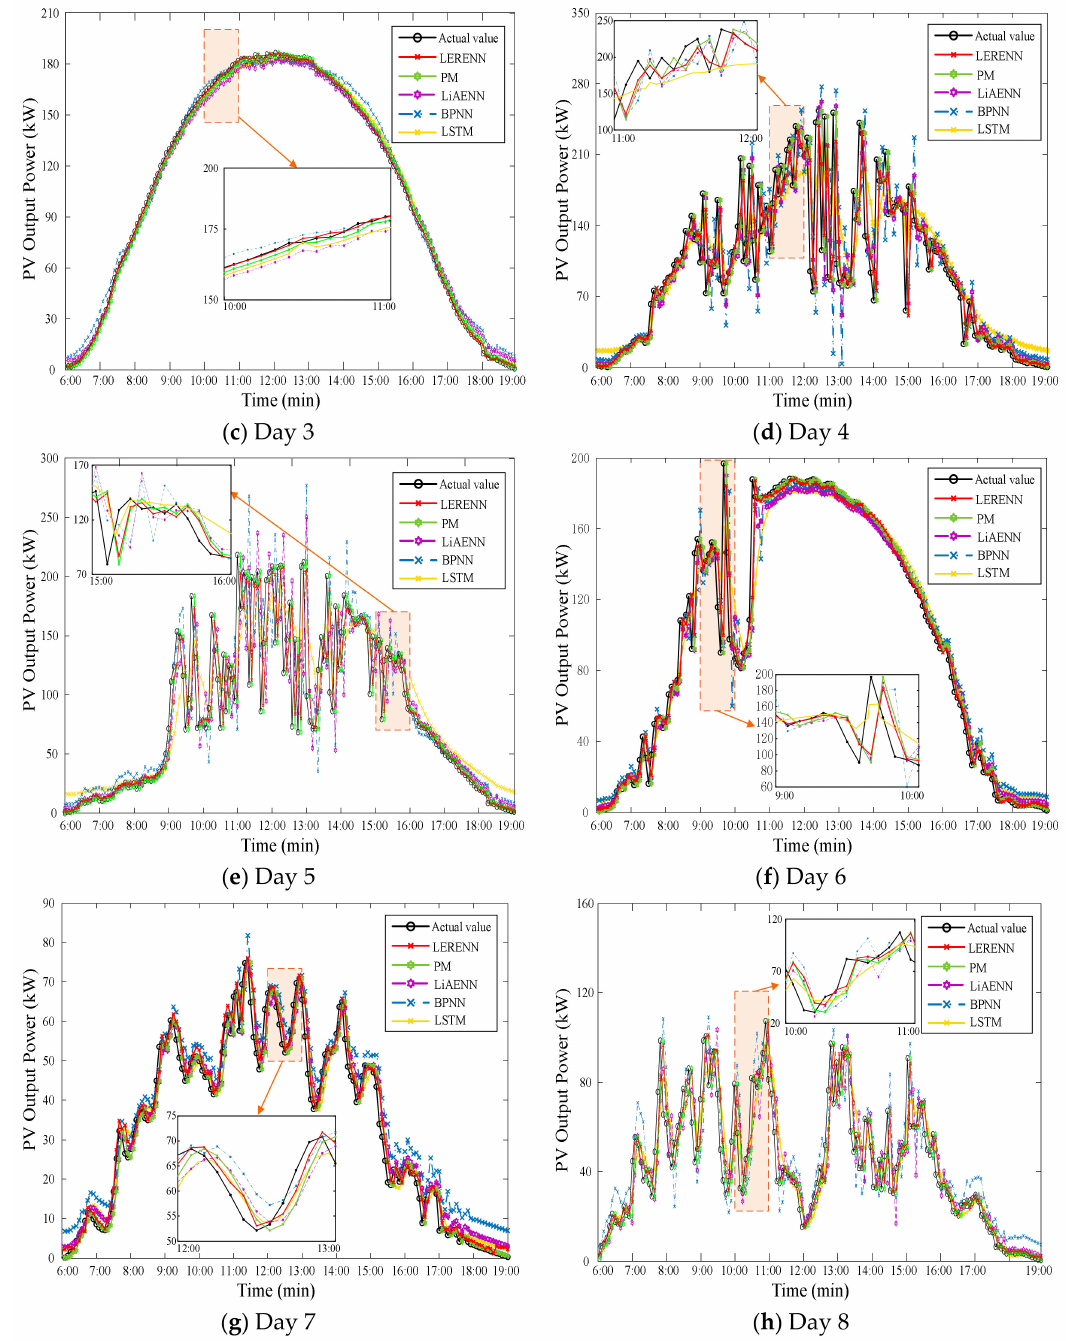
Figure 7. The results of single-step prediction of PV power in di ff erent weather